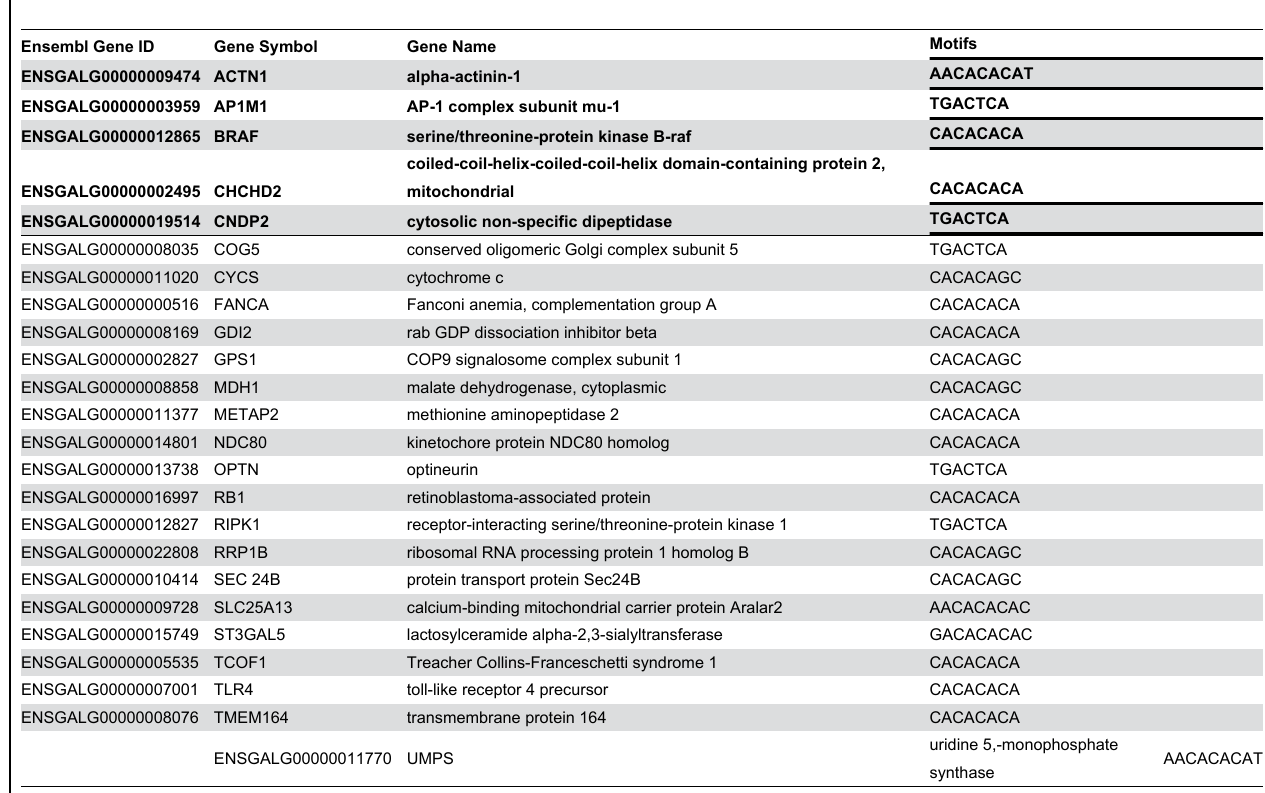
Table 2. Genes directly regulated by Meq that exhibit allele-specific expression (ASE) in response to MDV infection and have SNPs in the Meq-binding